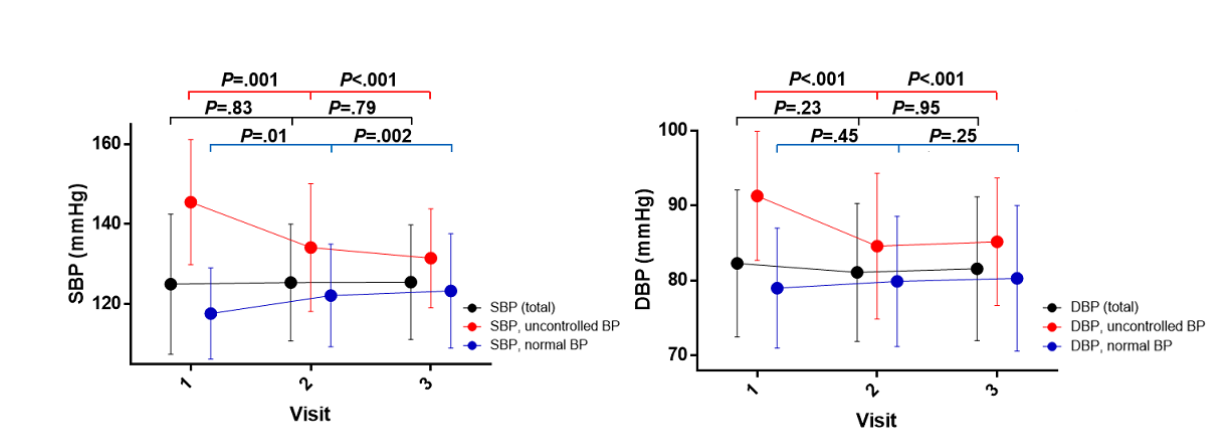
Figure 7. Different trends of systolic blood pressure (SBP) (left) and diastolic blood pressure (DBP) (right) reductions in patients with uncontrolled and normal blood